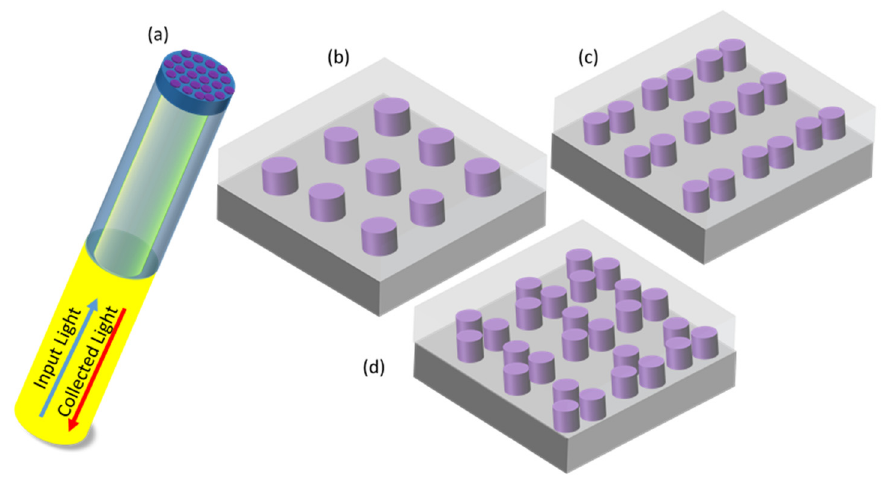
Figure 1. Schematic illustration of the studied geometries. ( a ) A schematic of a fiber with NSs fabricated on its tip. A square-periodic array of: ( b ) cylindrical Si NSs ( c ) dimers of Si cylindrical NSs and ( d ) trimers of cylindrical Si NSs on SiO 2 substrate in a homogeneous medium with a refractive index = 1.33.